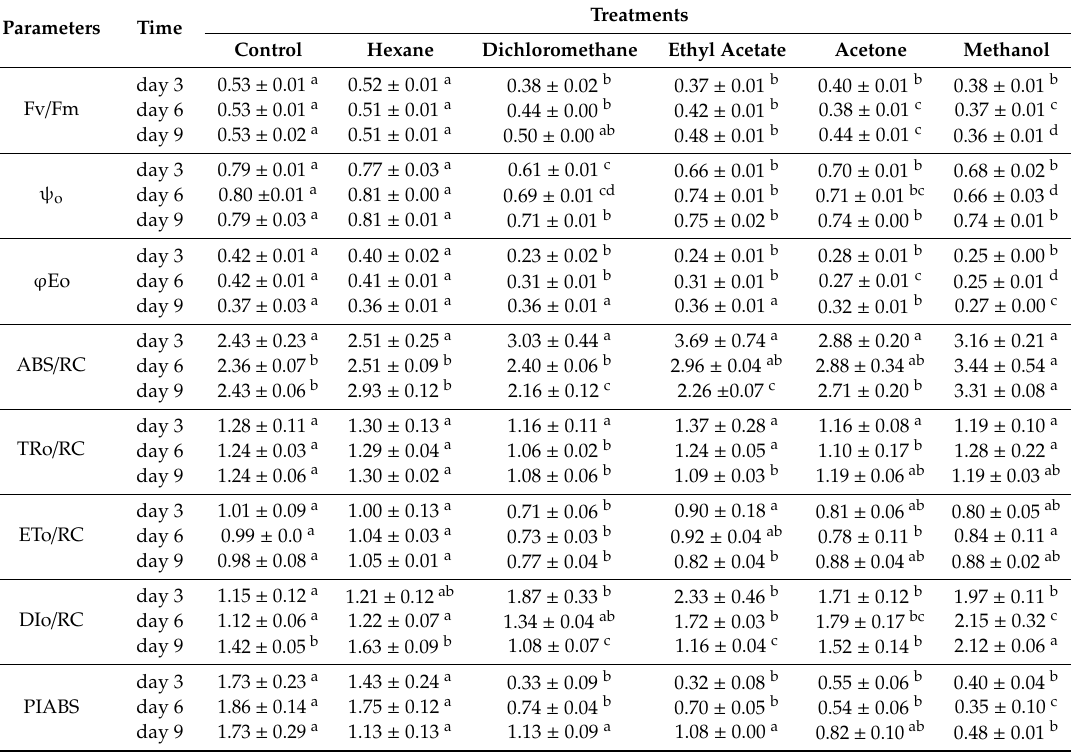
Table 3. The JIP test parameters of M. aeruginosa treated with the eluting fractions of SPE-enriched significant di ff erences among the control and the treatments on the same day at p < 0.05